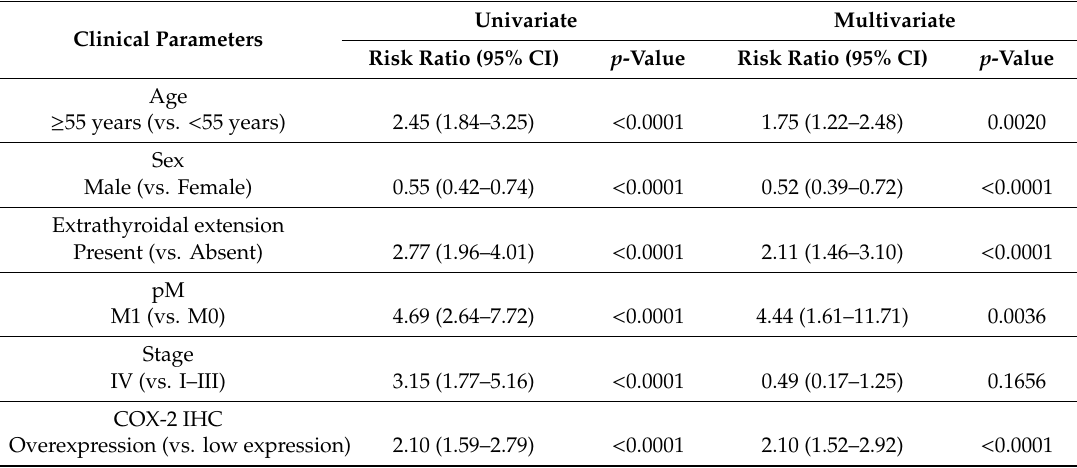
Table 4. Univariate and multivariate analysis of COX-2 expression in BRAF -mutant PTC using the Cox proportional-hazards